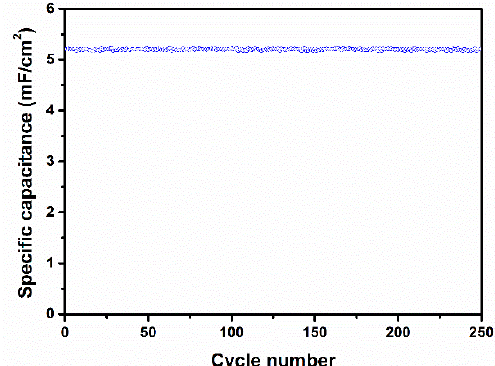
Figure 6. Variation of the specific capacitance of TiO 2 nanotube array electrodes as a function of cycle number measured at 100 mV/s.